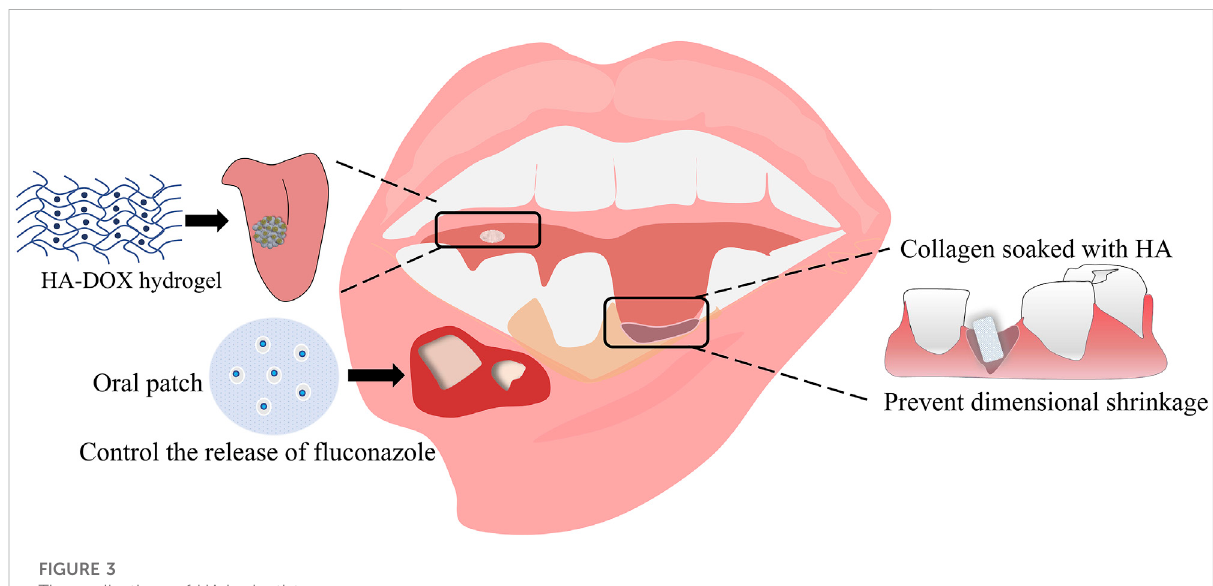
FIGURE 3 The applications of HA in